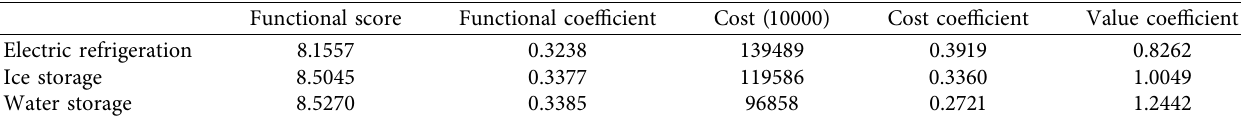
Figure 2: Expert-based scoring results. Table 8: Summary of the value engineering correlation